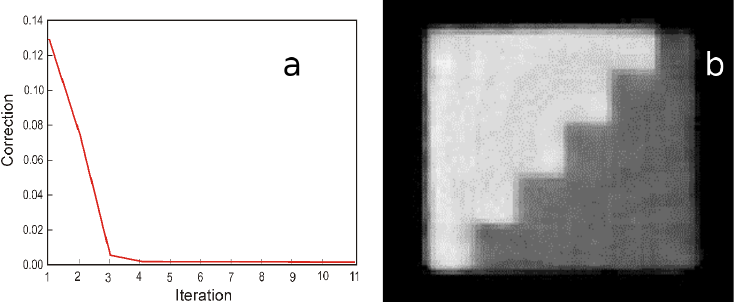
Figure 3. Average pixel change for each iteration, showing convergence after 11 steps ( a ) and the resulted image after 11 iteration of two joined objects evidencing a boundaries between materials ( b